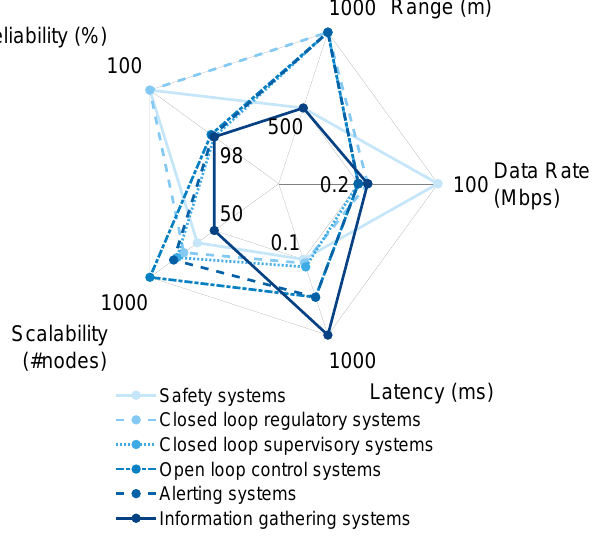
Figure 3. Different classes of industrial systems have significantly different performance